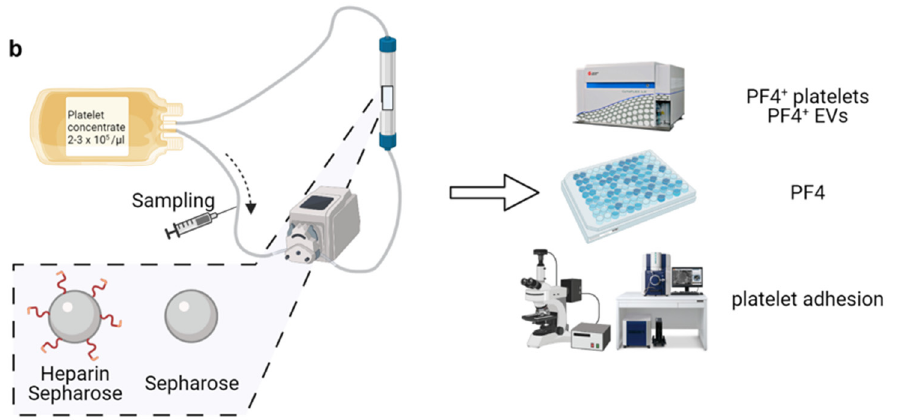
Figure 5. Experimental set-up. ( a ) Batch experiments. Plasma from sepsis patients ( n = 10) was incubated with 10 vol% of Seraph-100 or Heparin Sepharose, or with non-functionalized Sepharose as a control, as described in the methods section. Treated plasma was collected, and soluble PF4, histones/nucleosomes and HMGB1 were quantified by ELISA; ( b ) re-circulation experiments. The depletion of activated platelets and pEVs by the adsorbents was assessed by circulating activated platelets (2–3 × 10 5 /µL in SSP + medium anticoagulated with ACD-A 1:12; total volume 50 mL) over adsorbent columns packed with 5 mL Heparin Sepharose or with non-functionalized Sepharose as a control, at a flow rate of 1 mL/min. Samples were drawn immediately after platelet stimulation (baseline value) and after 30, 60 and 120 min of re-circulation. Figure created with BioRender.com (accessed on 20 December 2021).